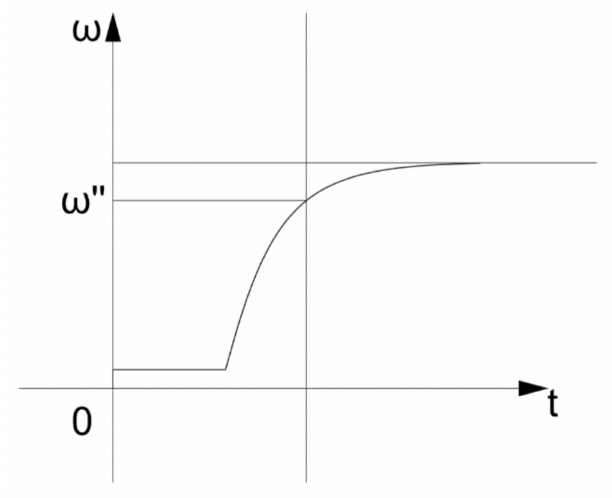
Figure 5. Preventive shutdown in Section